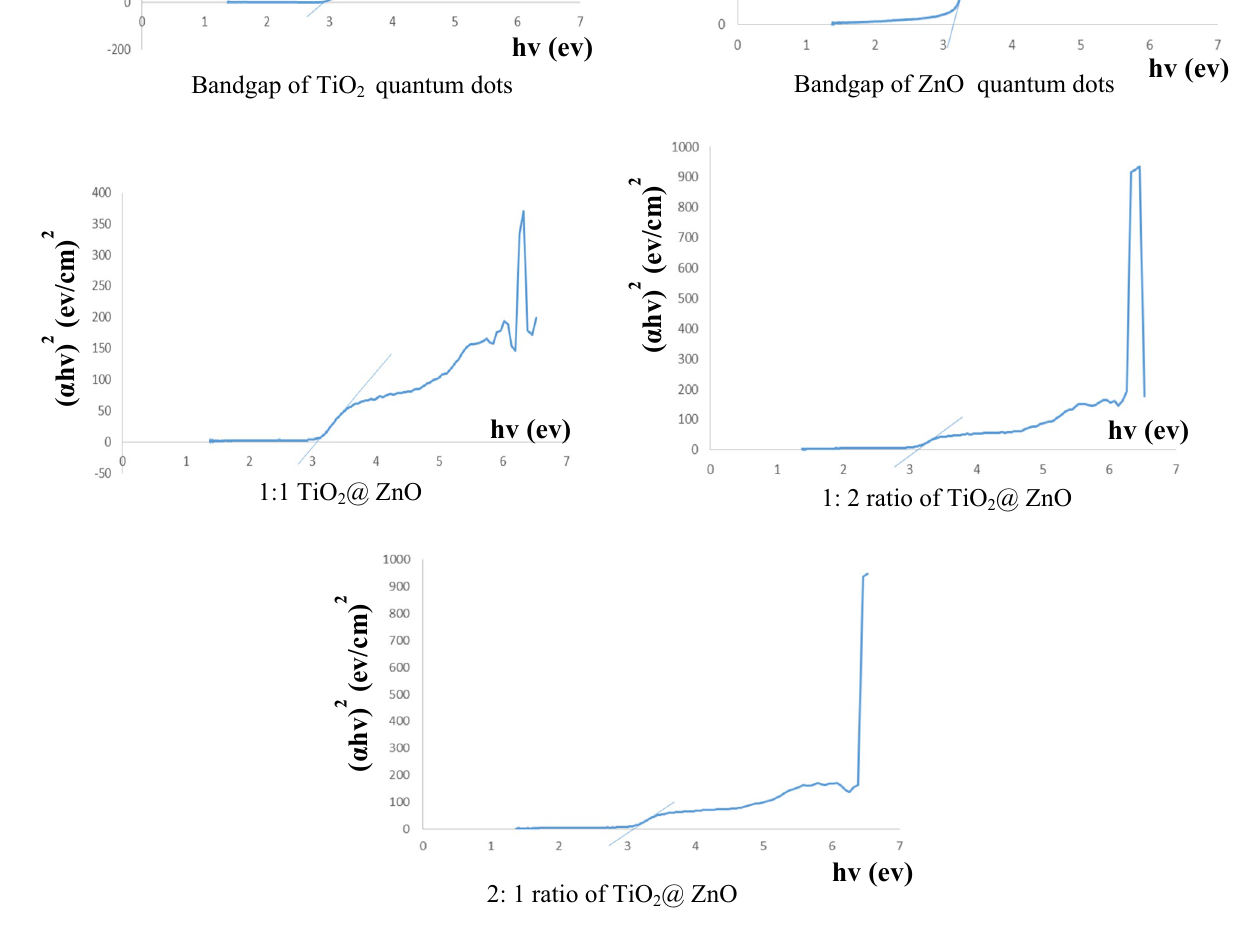
Figure 6. Bandgap of TiO 2 and ZnO quantum dots and their